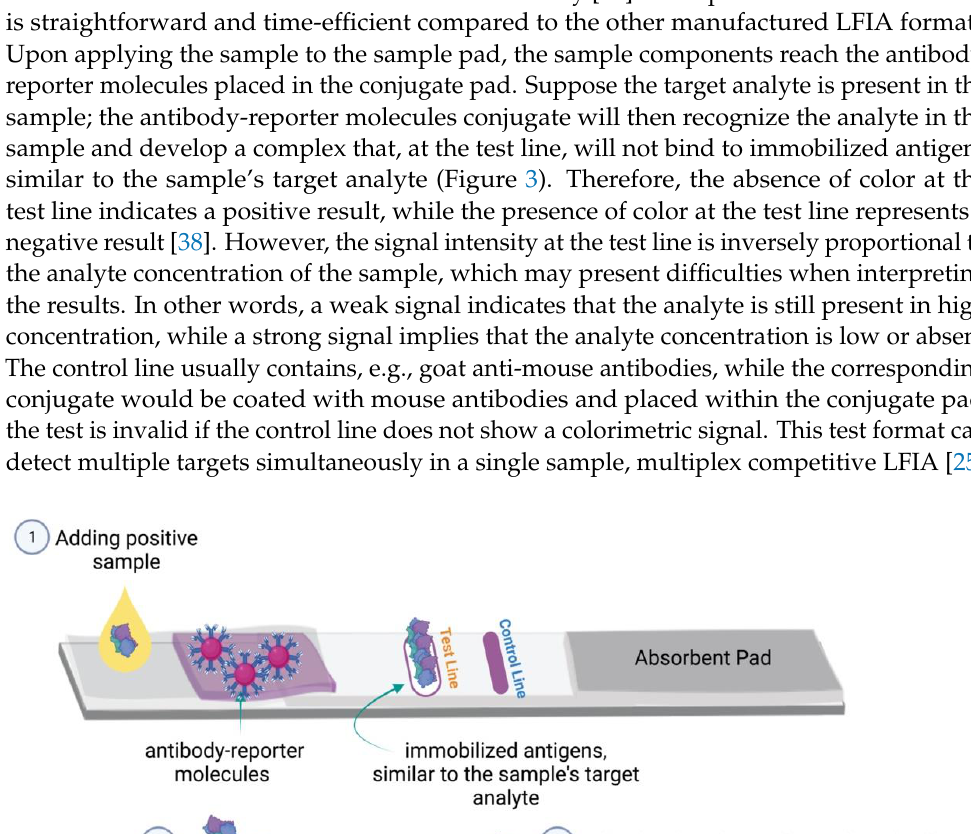
Figure 4. LFIA sandwich format: Schematic of the competitive format LFIA components and prin- ciples.